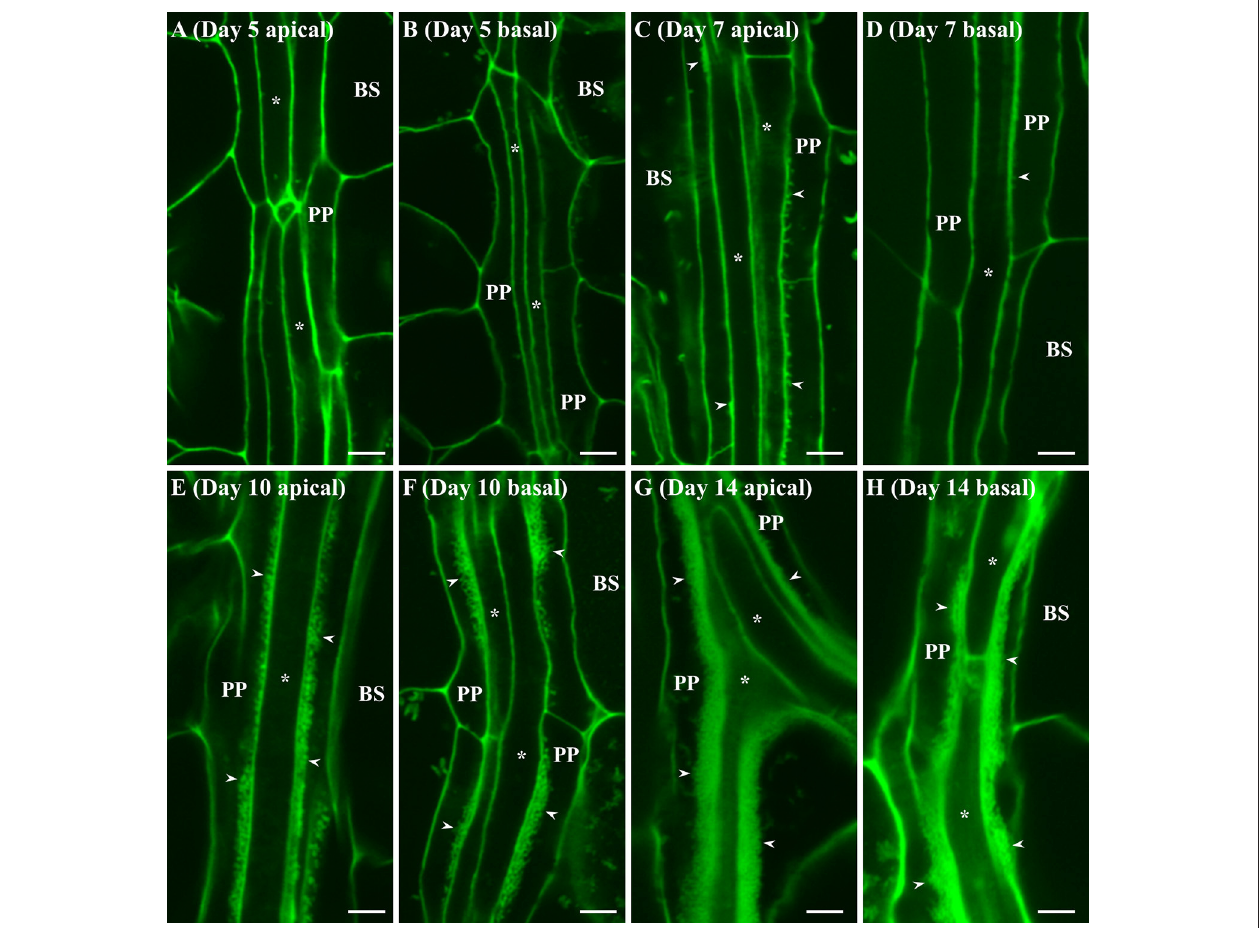
FIGURE 1 | Confocal imaging of wall ingrowth deposition in PP TCs of Arabidopsis cotyledons. No evidence of wall ingrowth deposition was detected in PP cells of either the apical (A) or basal (B) half of cotyledons at day 5. By day 7, evidence of wall ingrowth deposition was detected as discrete fluorescent projections in PP TCs in the apical region of cotyledons (C) but only early stages of such protuberances were seen in the basal region (D) . By 10 days, PP TCs in both apical (E) and basal (F) regions of cotyledons showed extensive wall ingrowth deposition along the SE/CC border of PP TCs. At day 14, wall ingrowths in PP TCs in both apical (G) and basal (H) regions of the cotyledon were massively deposited and occupied a considerable volume of the PP TC. BS denotes bundle sheath cells; asterisks indicate SE/CCs; PP denotes PP cell or PP TC, as appropriate; arrowheads indicate wall ingrowths in PP TCs. The fluorescent fragments occasionally seen in BS cells correspond to remnant starch grains not completely extracted by the bleach treatment. Scale bars = 5 µ